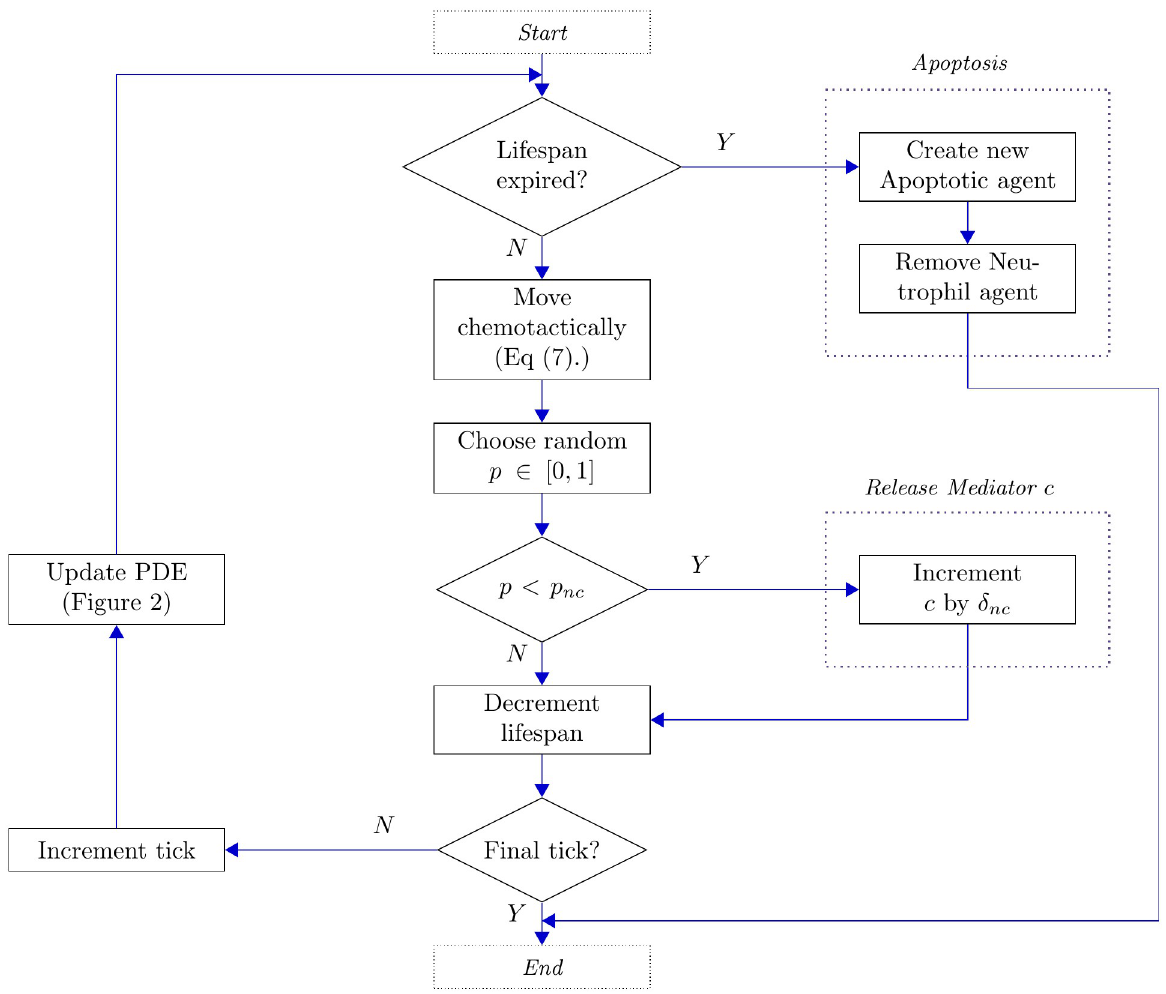
Fig 4. Flow chart illustrating the actions of each neutrophil